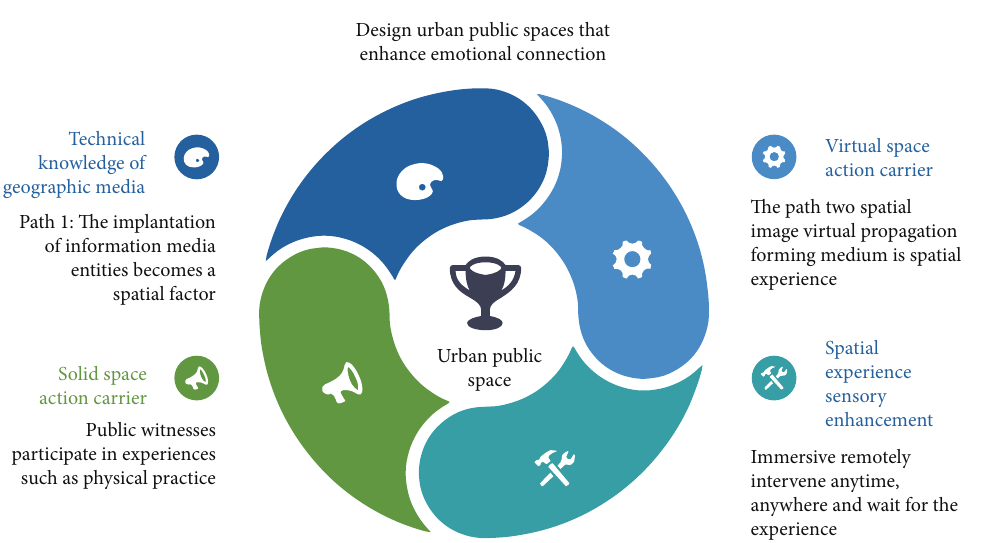
Figure 2: Urban public spaces designed to enhance emotional